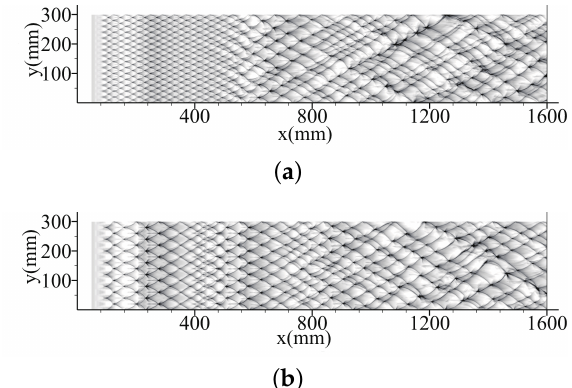
Figure 8. Numerical smoked foils for cases with artificial perturbations of A = 15 K, k R = 4 s − 1 , ( a ) s = 20 ∆ I , and ( b ) s = 40 ∆ I .